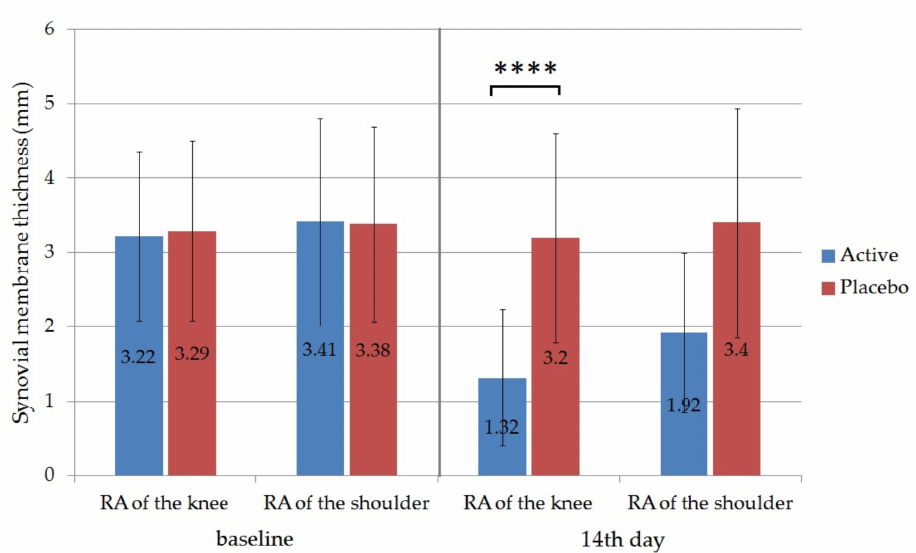
Figure 9. The ultrasonographically measurement of the synovial membrane thickness (mm). Values represent means ± SD. Unpaired t tests were performed to compare the active and the placebo groups with each other. Significant differences are marked on the figure with asterisks ( p < 0.0001). Active group was treated with Formula D containing APIs, while placebo group was treated with the same formula without APIs. Significant differences were detected between the synovial thickness of active and the placebo group on the 14th day in the case of patients with RA of the